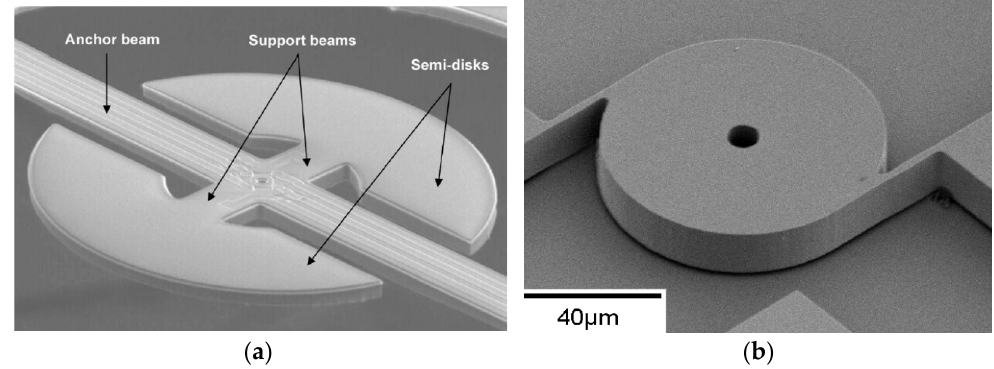
Figure 17. SEM of piezoeresistively-sensed thermally-actuated resonator: a rotational disk resonator with boron-doped piezoresistive readout element ( a ) and a solid single crystalline silicon disk resonator with combined heater/piezoeresistive silicon beams ( b ) [147]. © 2010 IEEE. Reprinted with permission from Rotational mode disk resonators for high-Q operation in liquid by A. Rahafrooz in Proceedings of the 2010 IEEE Sensors, 2010.